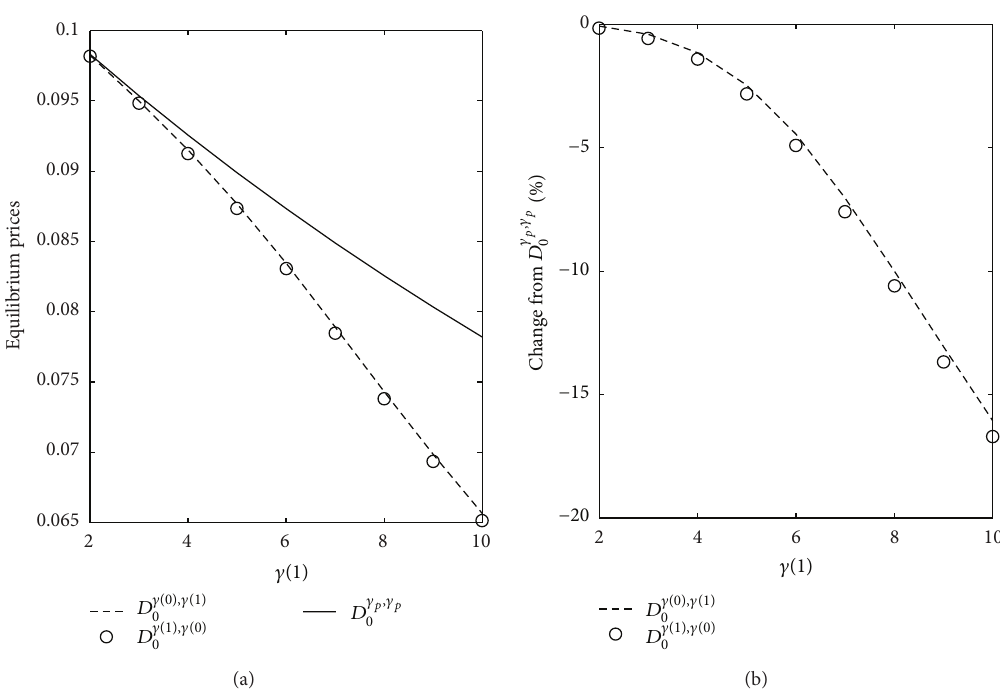
𝛾 𝑝 ,𝛾 𝑝 0 and the subgame perfect equilibrium prices.